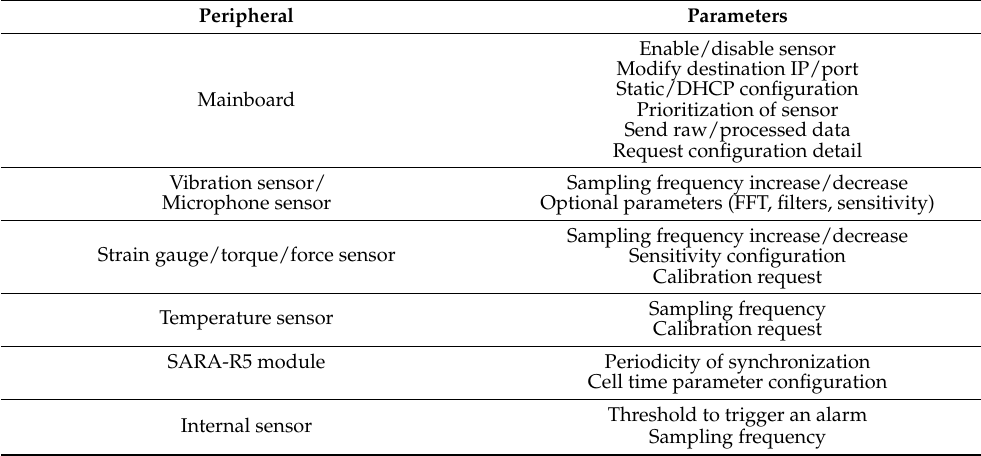
Table 1. LWM2M. Client